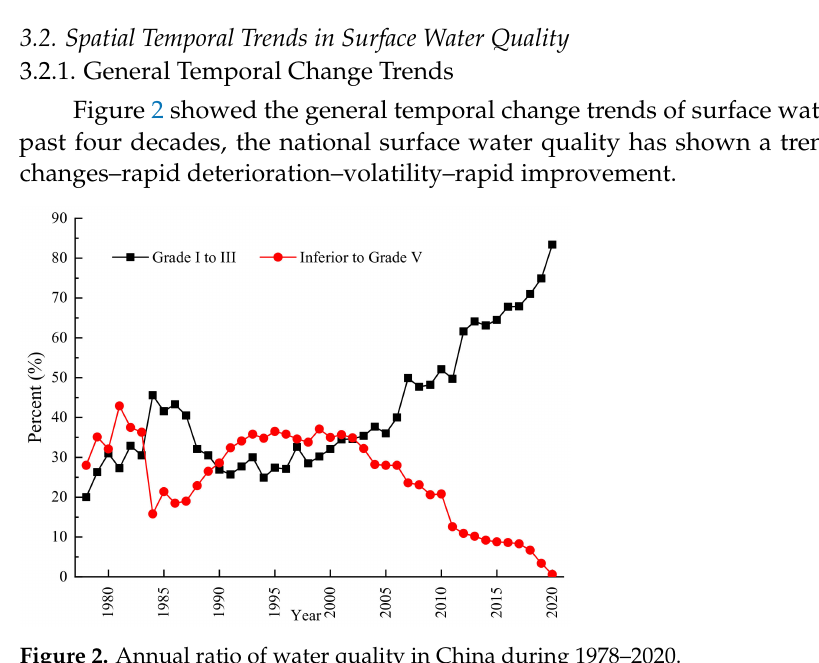
Figure 2. Annual ratio of water quality in China during